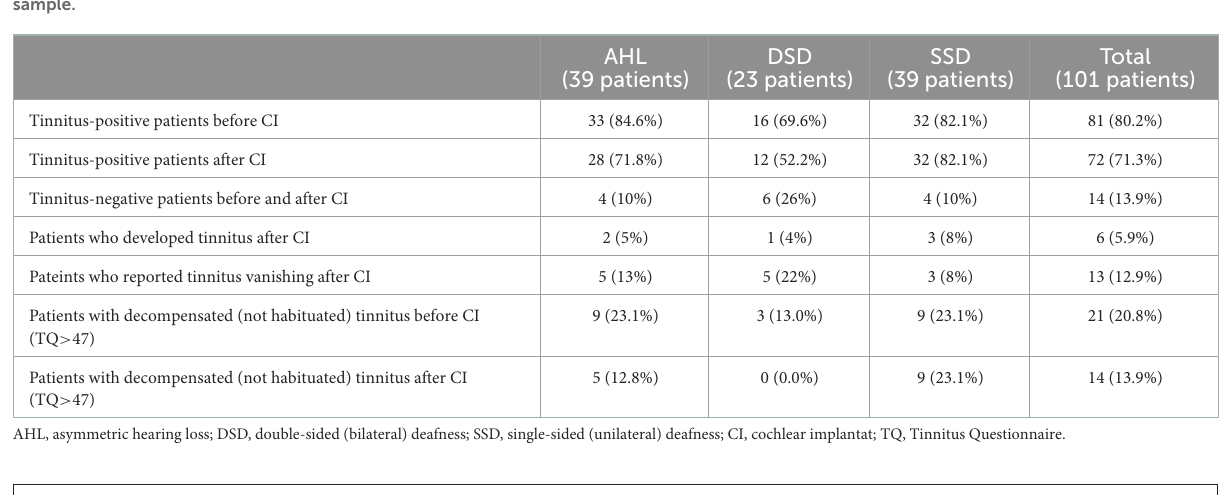
TABLE 2 Contingency table showing tinnitus prevalence and degree of tinnitus-induced distress before and after CI for each group and the whole sample.